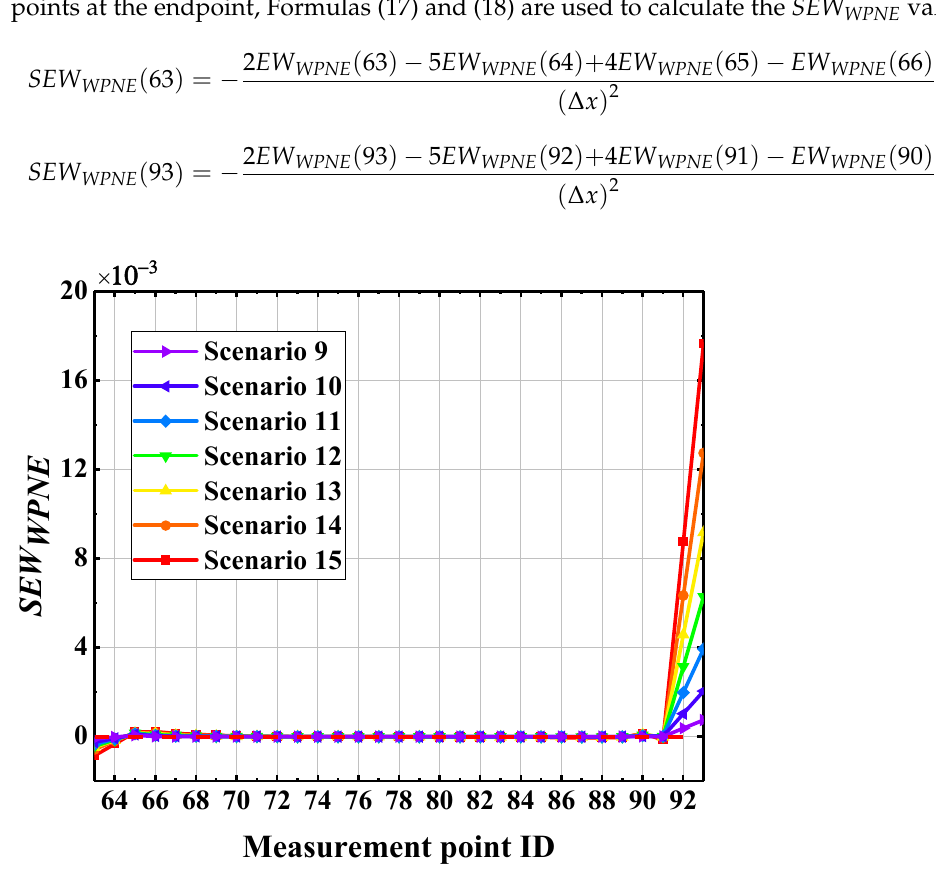
Figure 12. Modified identification results of damage II using index SEW WPNE .